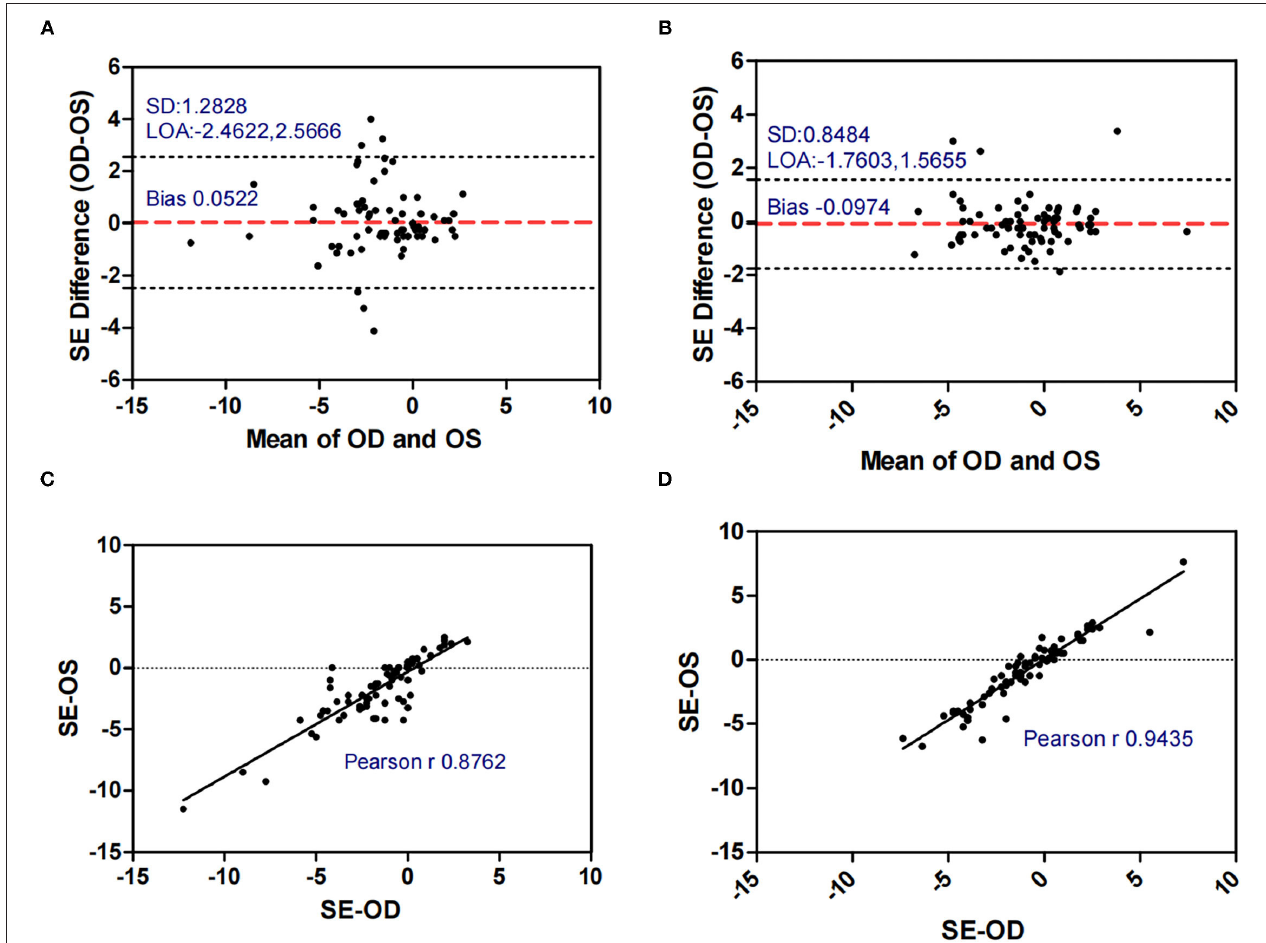
FIGURE 1 | Bland-Altman plots (A,B) and scatter plots (C,D) of SE in concomitant exotropia (A,C) and normal control participants (B,D) of the left and right eyes. OS, left eye; OD, right eye; SE, spherical equivalent; LOA, 95% limits of agreement.